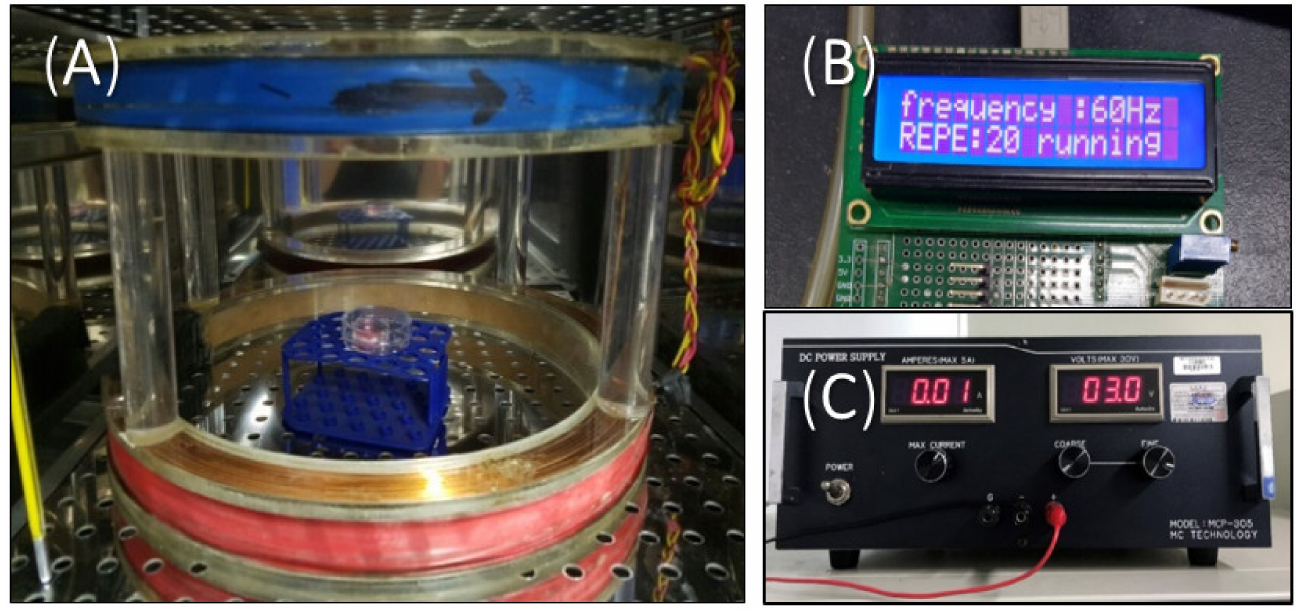
Figure 1. Photograph of the ELF-EMF device in a 5% CO 2 incubator at 37 ◦ C. ELF-EMF was generated